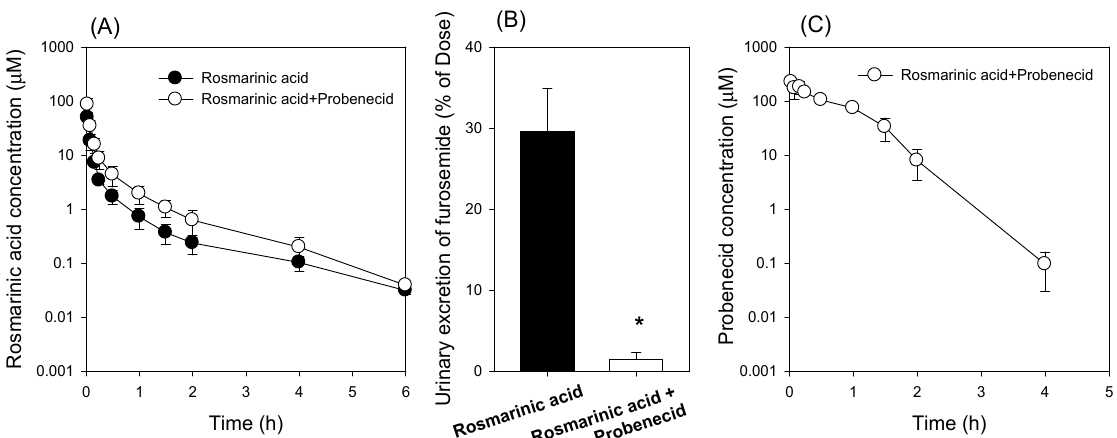
Figure 4. ( A ) The plasma concentration-time profile and ( B ) urinary excretion of rosmarinic acid following the intravenous injection of rosmarinic acid (1 mg/kg) in the absence ( ● ) or presence ( ○ ) of probenecid (10 mg/kg). ( C ) Plasma concentration-time profile of probenecid following intravenous injection of probenecid (10 mg/kg) and rosmarinic acid (1 mg/kg). Each data point represents the mean ± standard deviation ( n = 4). * p < 0.05 compared with rosmarinic acid group. Table 2. Pharmacokinetic parameters of rosmarinic acid and probenecid in rats. Parameters